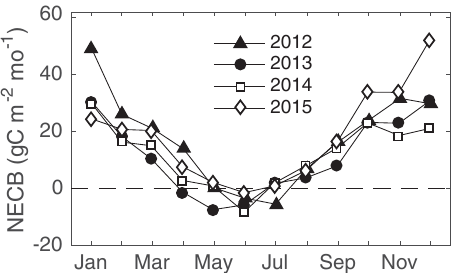
Figure 5. Monthly total net ecosystem carbon balance (NECB) at Kopuatai bog over the 4 measurement years.